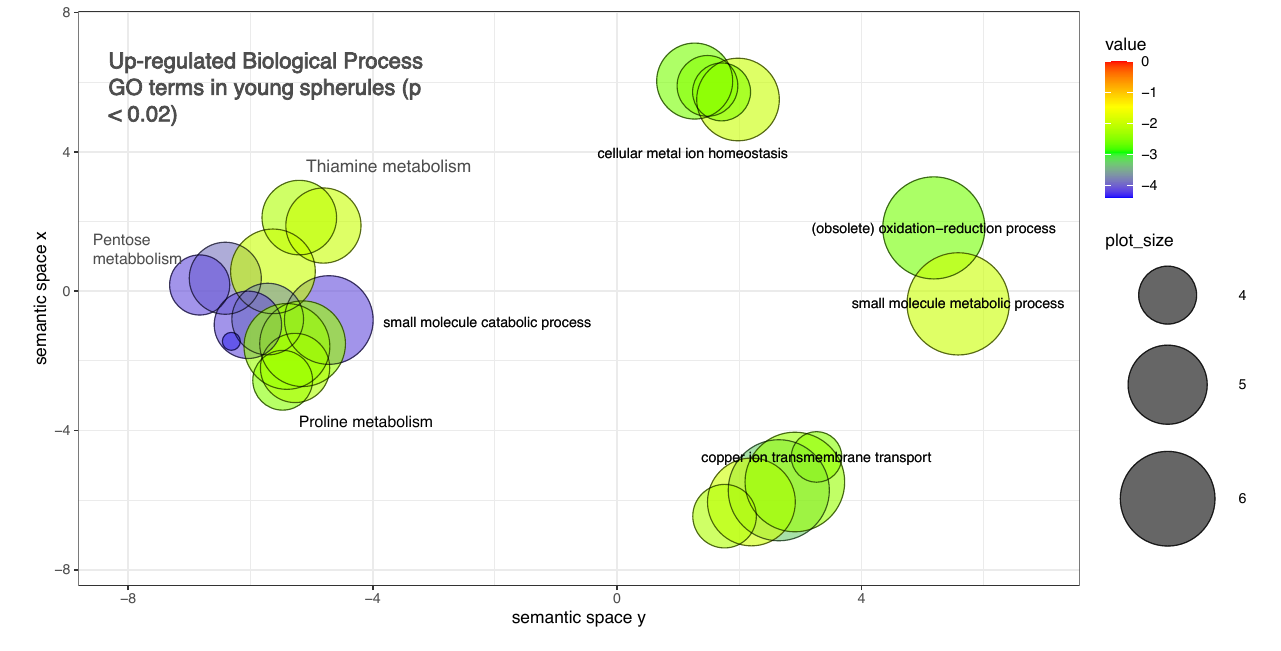
Figure 12. Biological GO terms enriched in spherules. Principle component analysis (PCA) plot of enriched GO terms of genes up-regulated in spherules, made using Revigo. The data for this figure is from